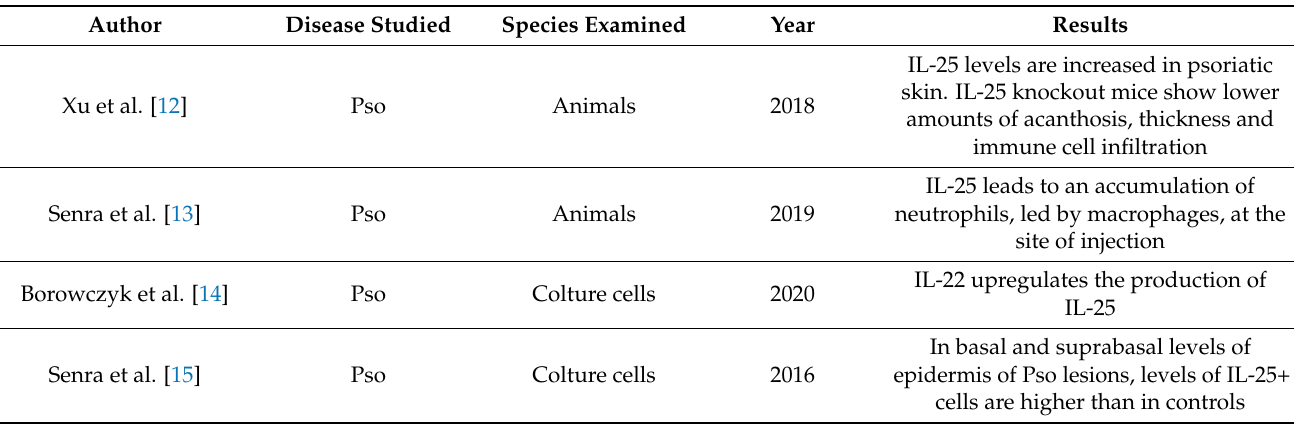
Table 1. Interleukin 25 and skin. The results include both psoriasis and atopic dermatitis. The results are ordered by year and a quick overview is presented by author’s name, disease studied, species examined and results.